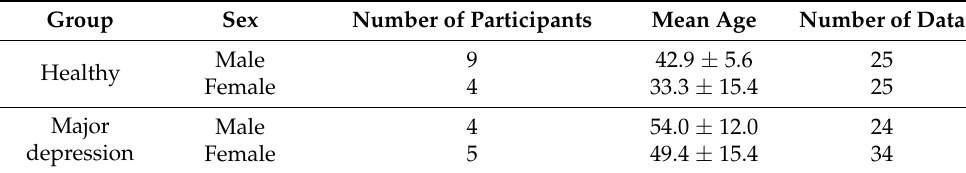
Table 1. Experimental participant information for algorithm preparation.